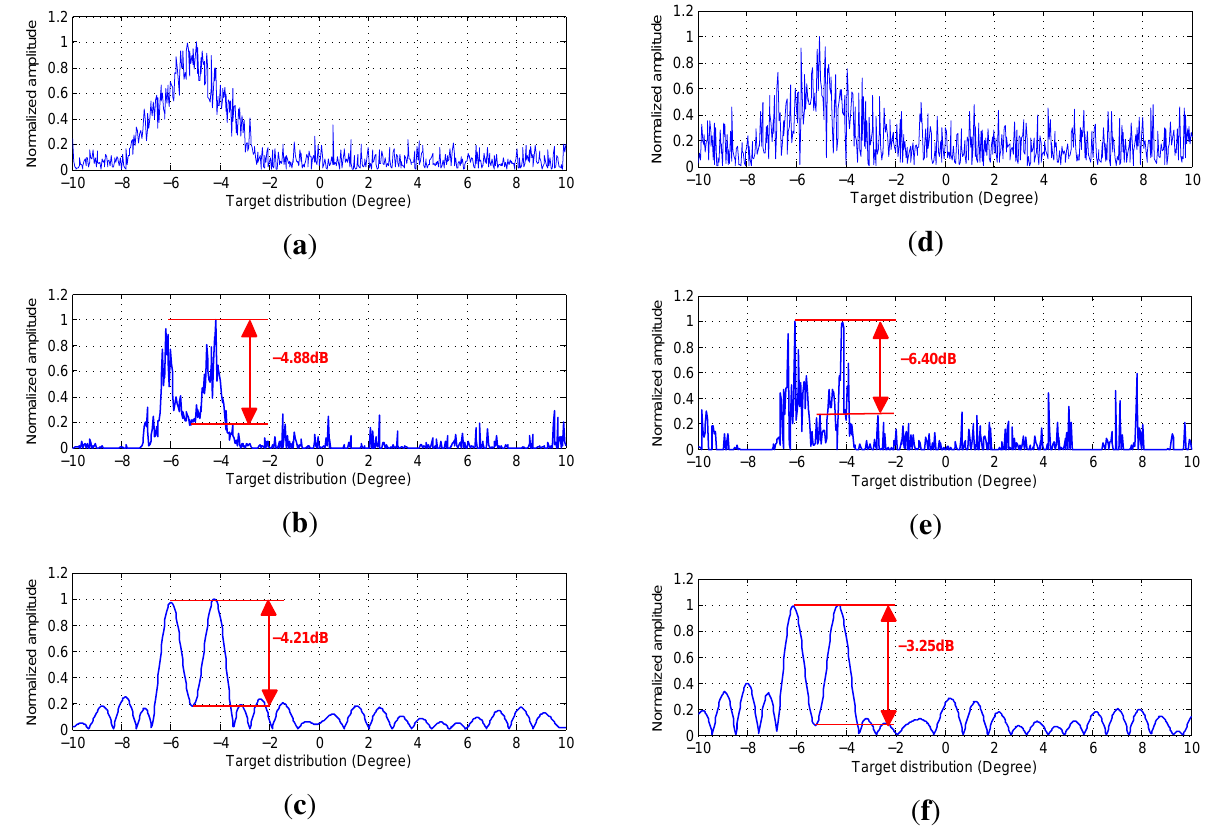
Figure 6. Angular super-resolution results obtained using different methods under SNR = 10 dB and 5 dB, respectively. ( a ) Echo data with noise level is 10 dB; ( b ) Angular super-resolution result of Guan’s method after 15 iterations; ( c ) Angular super-resolution result of the proposed method; ( d ) Echo data with noise level is 0 dB; ( e ) Angular super-resolution result of Guan’s method after 35 iterations; ( f ) Angular super-resolution results of the proposed method.